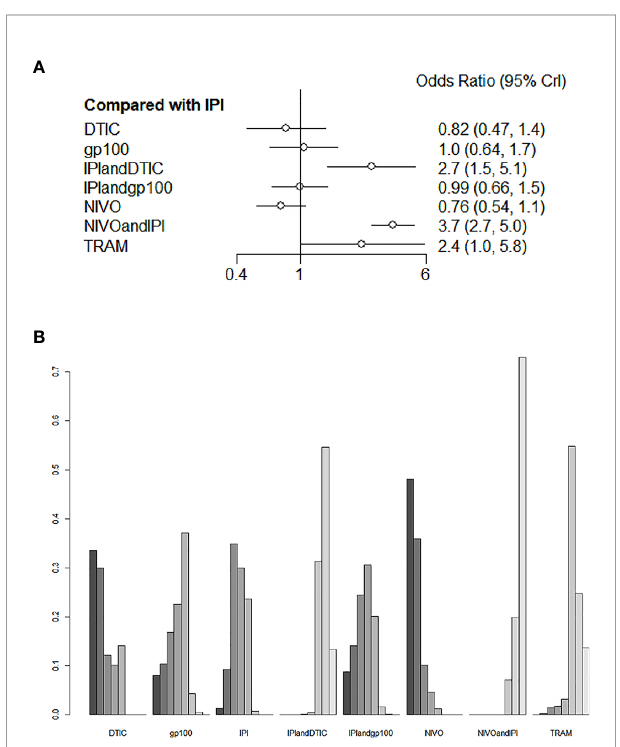
FIGURE 6 | Direct and indirect comparisons for AEs (A, B) among IPI+DTIC, IPI+gp100, DTIC, IPI, gp100, NIVO, NIVO+IPI,